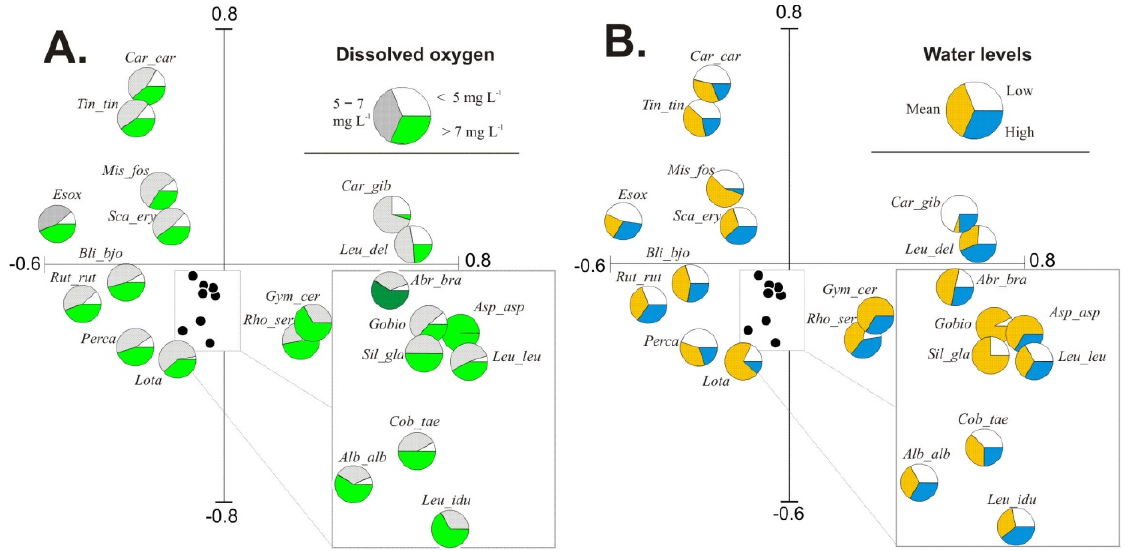
Figure 3. Biplots of CCA with species pies classes distinguished for: ( A ) water aeration (dissolved oxygen, DO in mg·L − 1 ); and ( B ) zones of water levels: low; mean and high water. Each pie chart in the figure represents the percentage of individuals of a given species in selected classes of dissolved oxygen and water levels. Rare species were down weighted. For fish abbreviations, see Table 2.